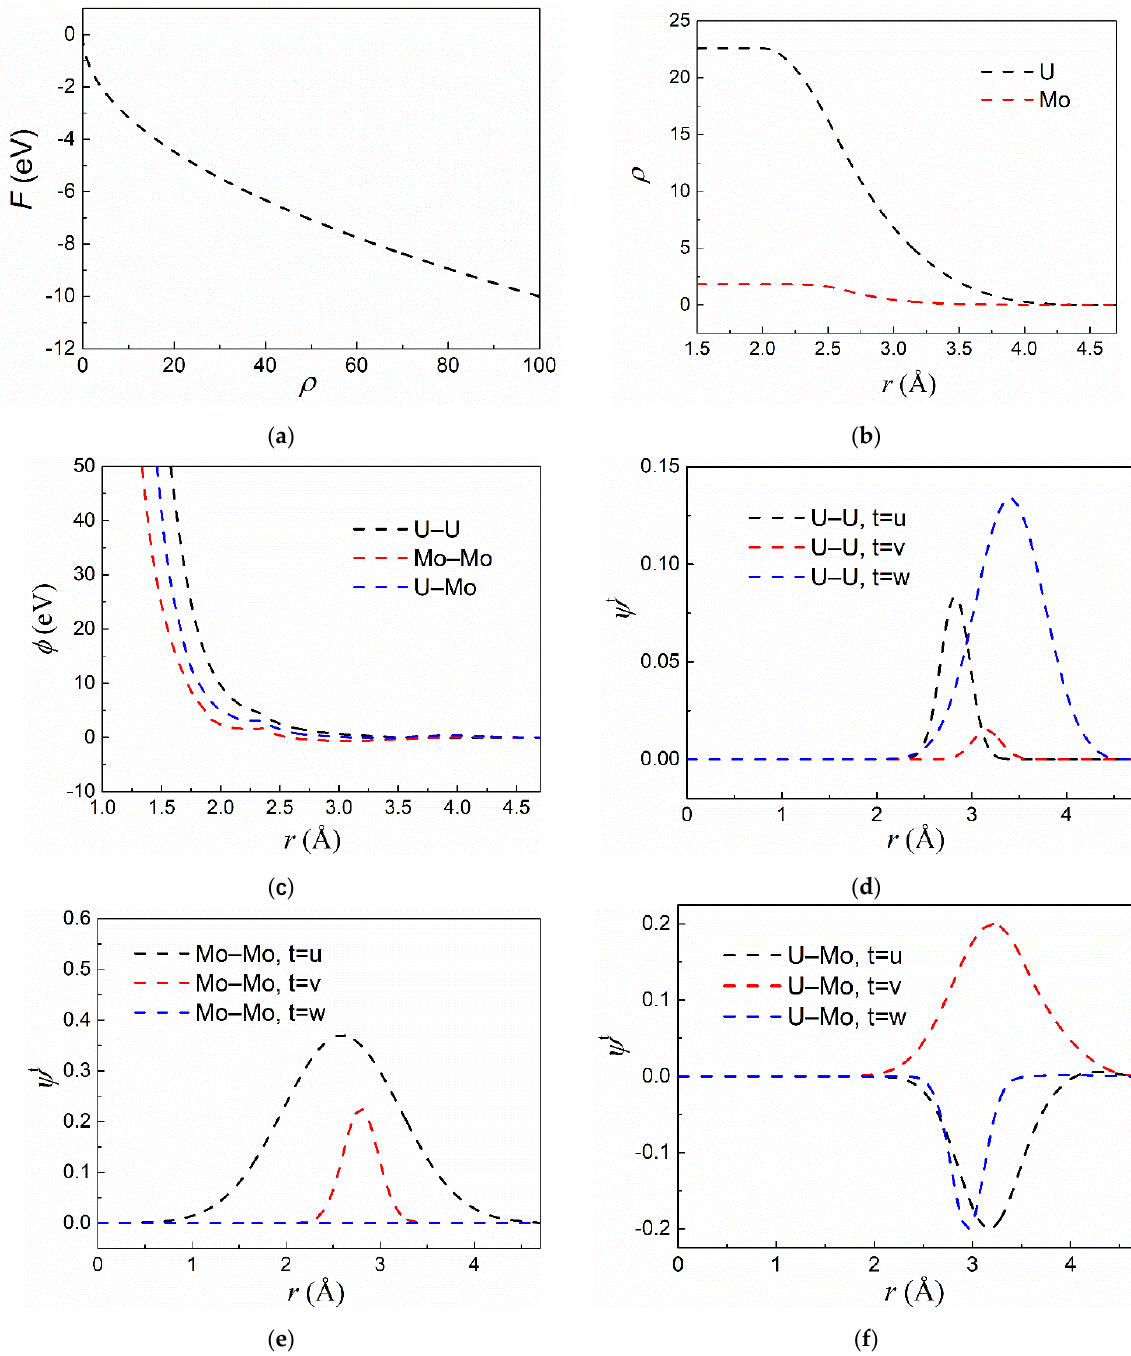
Figure 3. Potential functions of the newly developed ADP. Embedding function F , electron density function ρ and pair potential φ are shown in ( a – c ), respectively; angular-dependent terms of ψ u , ψ v and ψ w are grouped together and plotted for elemental pairs of ( d ) U–U, ( e ) Mo–Mo and ( f ) U–Mo.